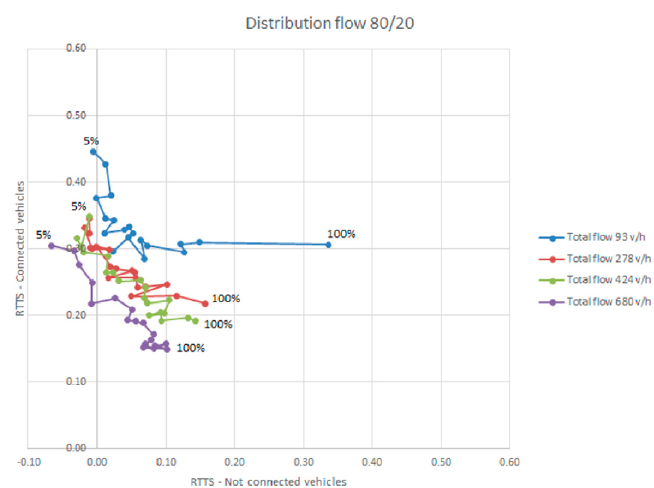
Figure 9. Ratio of Travel Time Saving for traffic light cycle B (Distribution of flow 60/40).